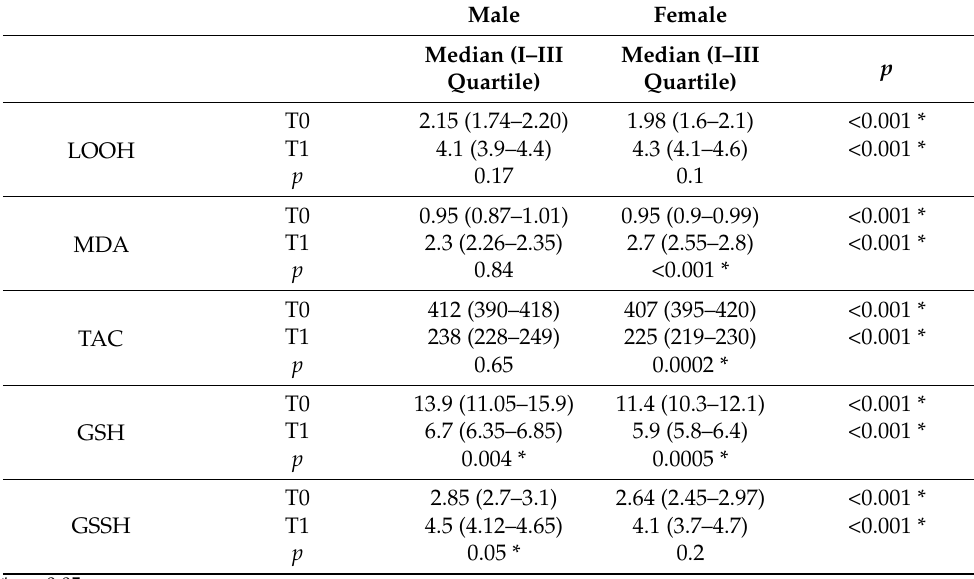
Table 2. Intra and Inter